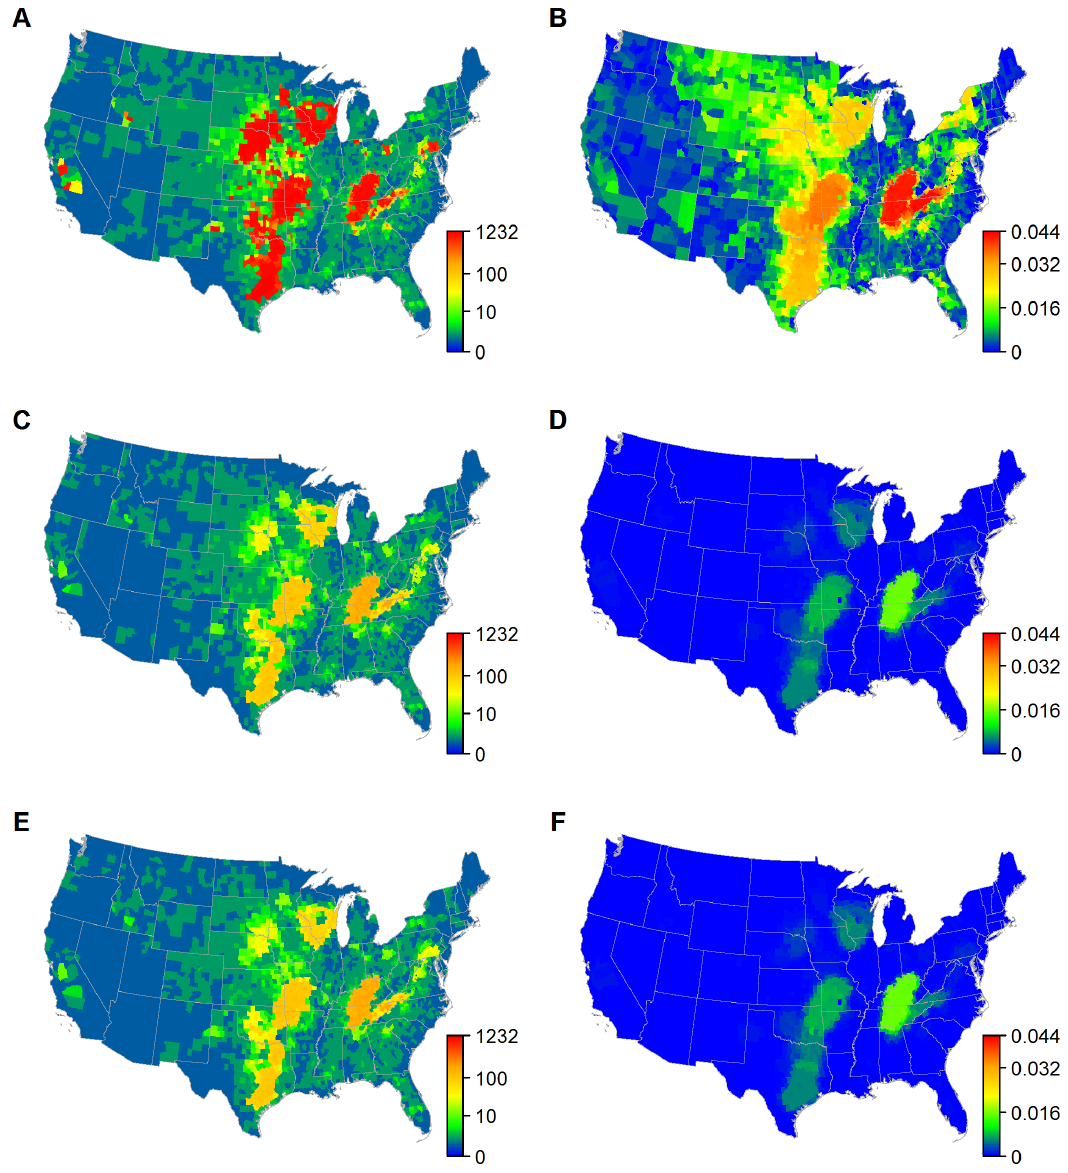
Figure 5. Epidemic extent and infection risk with unrestricted, county and, state movement bans. Upper tail of the distribution (based on the 97.5 th percentile of 100 simulations) for epidemic extent and infection risk when infections are introduced to each of the 3109 counties of the continental US. (A & B) assume standard movements while (C & D) assume a county-level movement ban and (E & F) assume a state-level movement ban. (A, C, & E) the epidemic extent (the number of counties infected) for an infection seeded in each county. (B, D, & F) the infection risk (the proportion of all simulated outbreaks that infect a county).